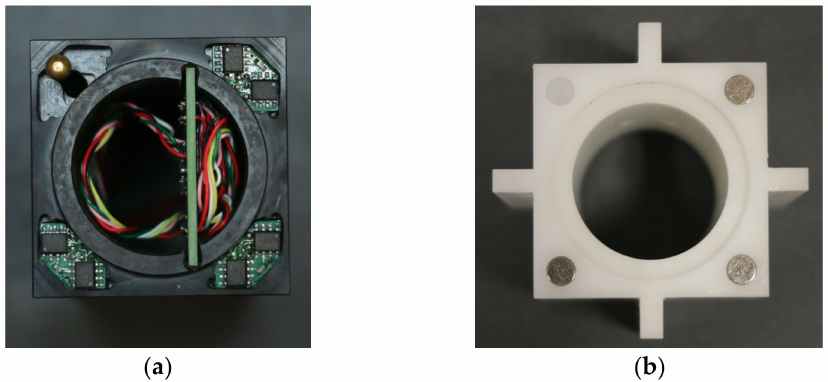
Figure 6. ( a ) Instrumented filler brick with Hall effect sensors and custom data acquisition board installed. ( b ) Instrumented interstitial brick with magnets installed.